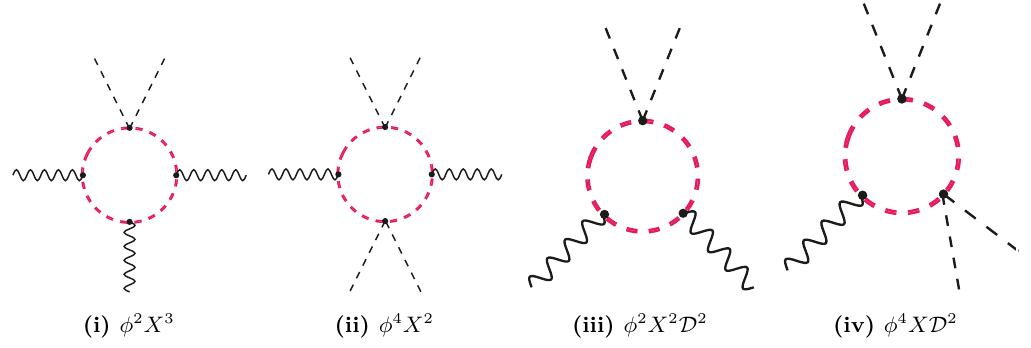
Figure 8. One-loop schematic diagrams revealing heavy field propagators enveloped within (i)